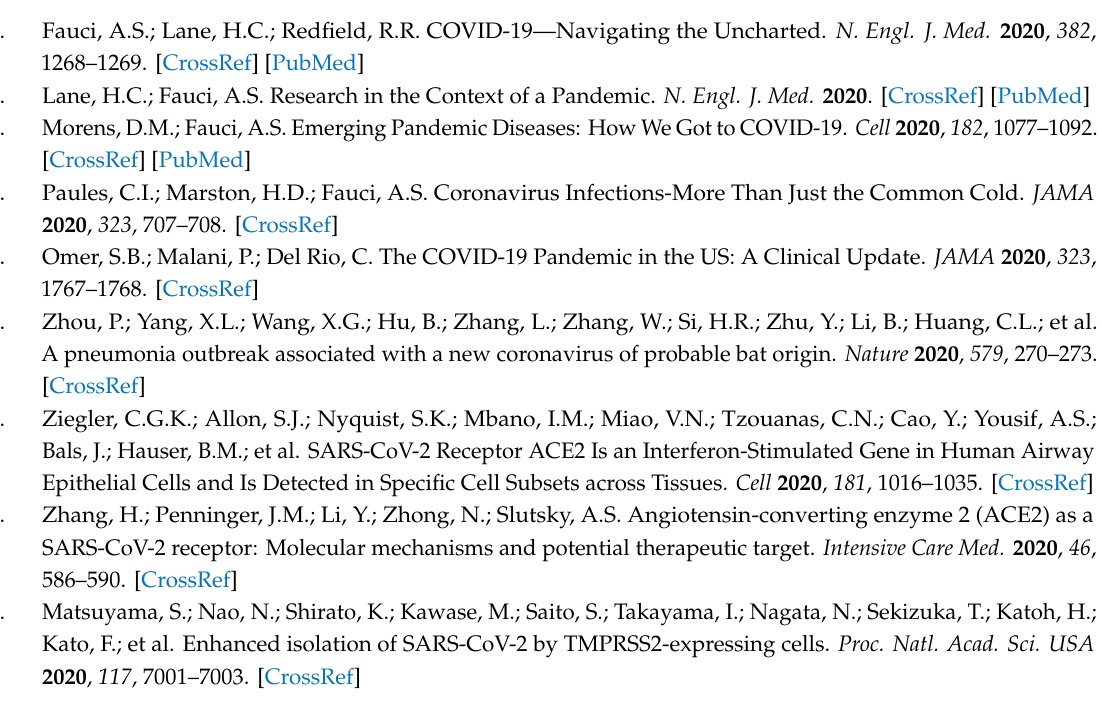
Table S1, title: Sequences of oligonucleotide primers and product sizes; Figure S1, title: TMPRSS2 expression is significantly reduced by